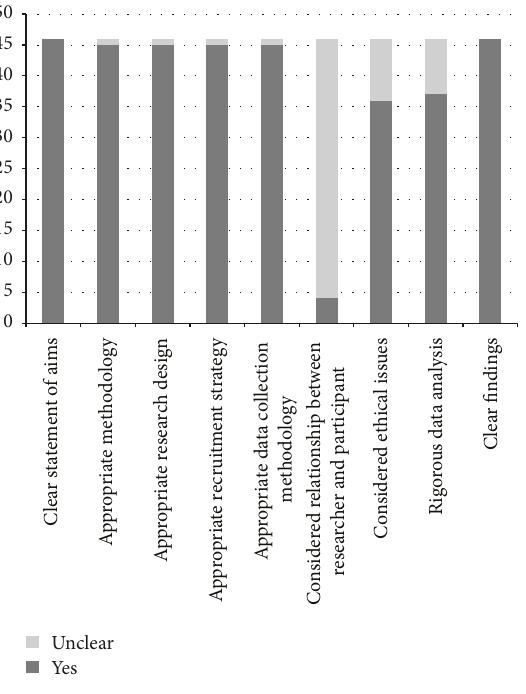
Figure 2: CASP Quality Assessment